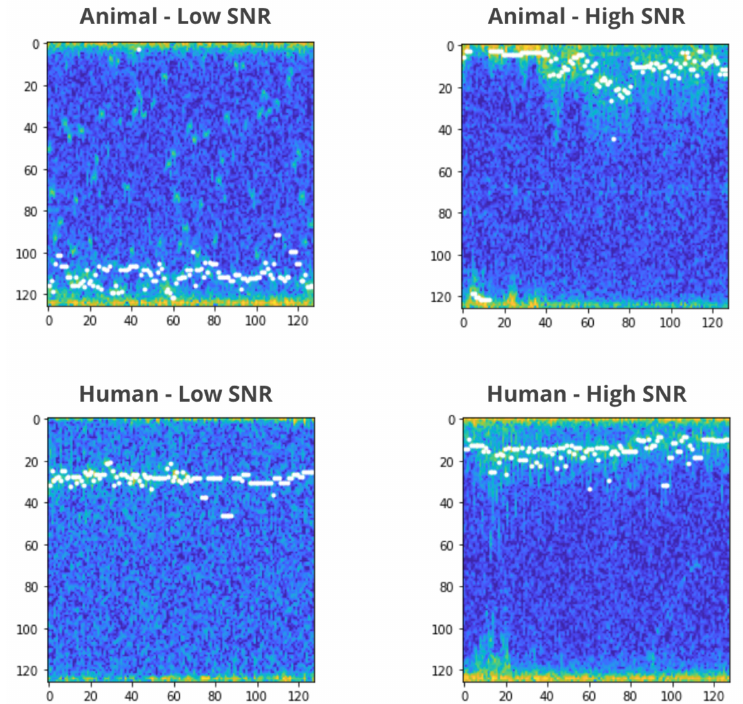
Figure 2. Examples of